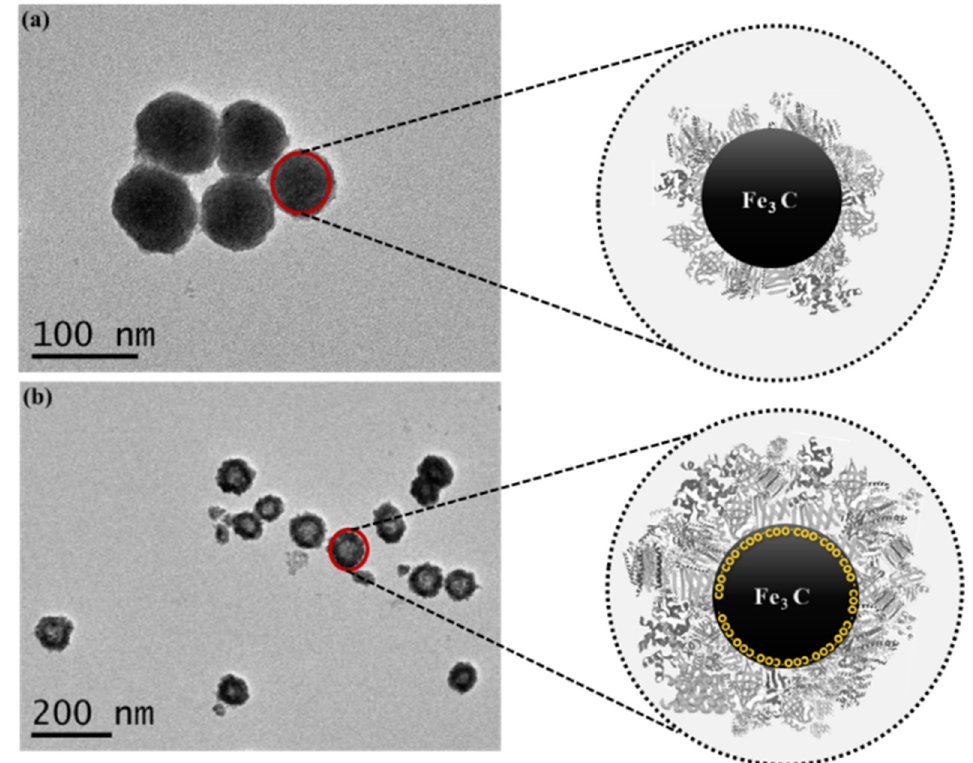
Figure 2. TEM images of ( a ) non-coated Fe 2 C NPs and ( b ) COOH coated Fe 2 C NPs, while zoomed images show possible protein corona.